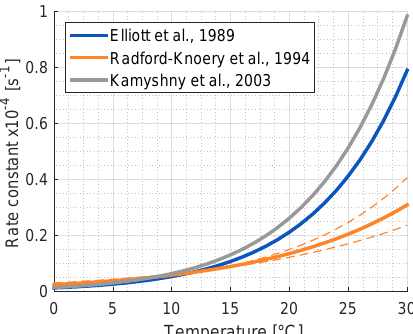
Figure 6. Comparison of published hydrolysis rates for OCS based on laboratory experiments with artificial water (Elliott et al., 1989; Kamyshny et al., 2003), and under oceanographic conditions using filtered seawater (Radford-Kne¸ry et al., 1994). The graph is replot- ted using equations from original papers at a pH of